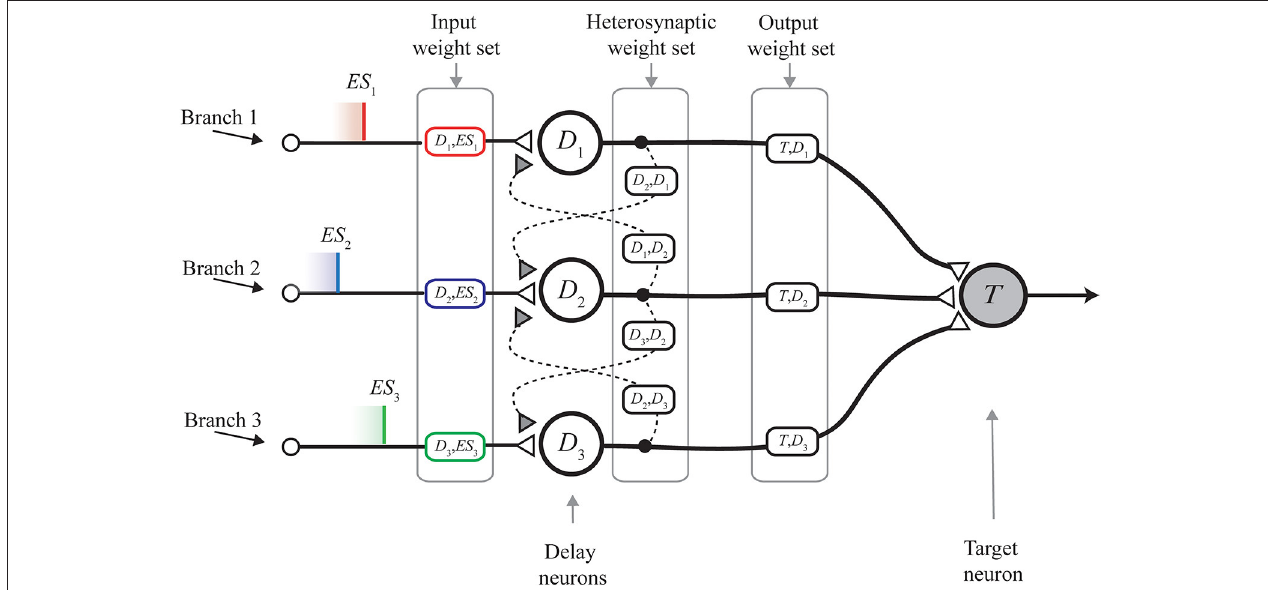
FIGURE 1 | Multi-neuronal spike sequence detector (MNSD) structure hit by the parallel spike train ES 1 , ES 2 , ES 3 . The different sections of the structure are shown. From left to right : input weight set, heterosynaptic weight set, output weight set; delay and target neuron are indicated with D i and T , respectively. Modified from Susi et al. (2018).